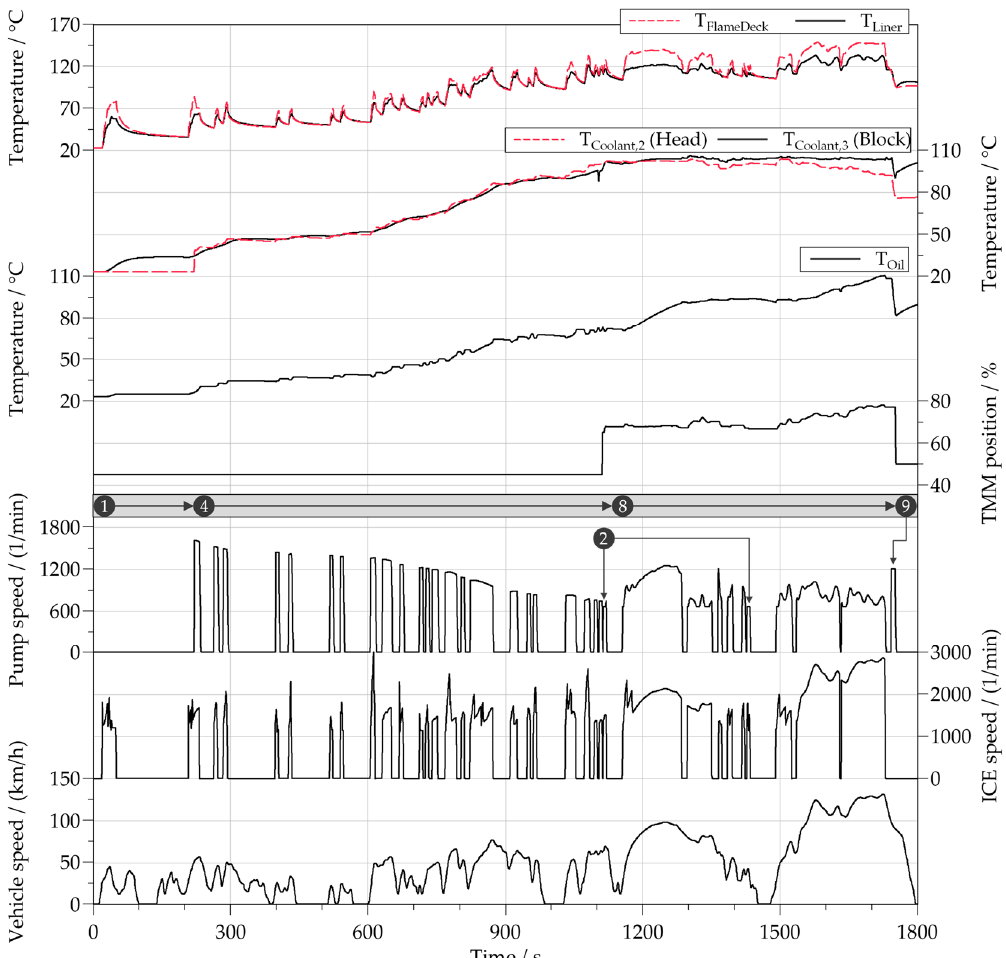
Figure 10. WLTC simulation results of the advanced thermal model at 23 °C ambient temperature.